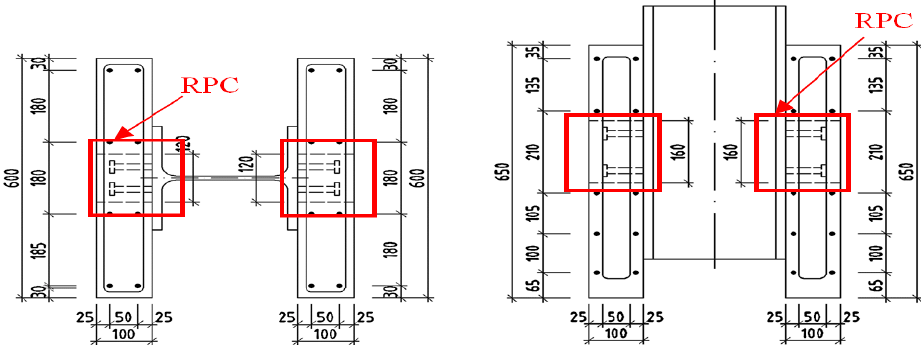
Figure 6. Push-out specimen of RPC with steel S1–2 and basalt B1–2 fibers.